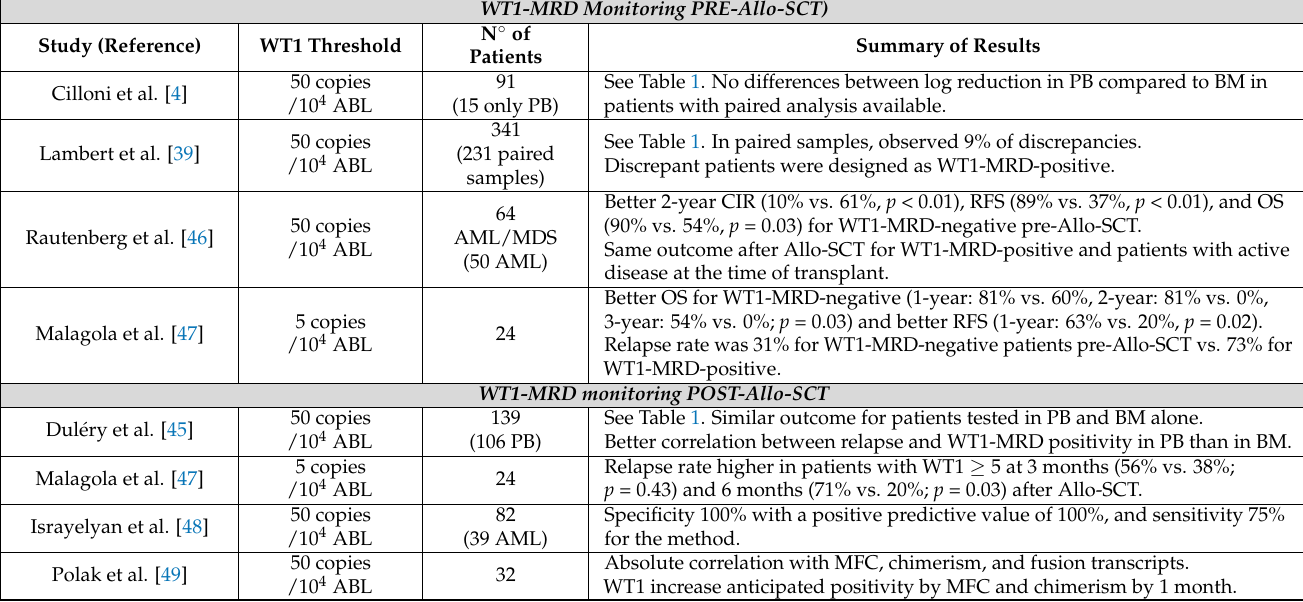
Table 2. Summary of the studies exploring the role of WT1-MRD monitoring in PB. WT1-MRD Monitoring